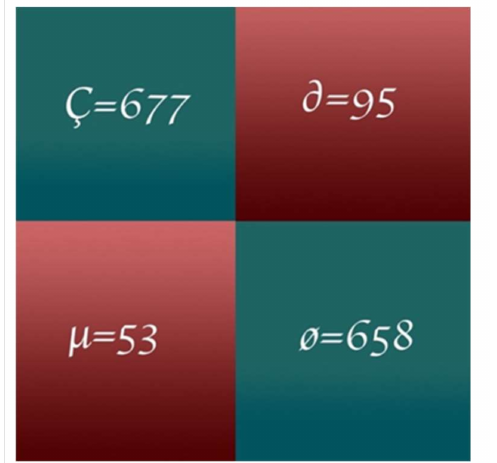
Figure 7. Proposed model testing confusion